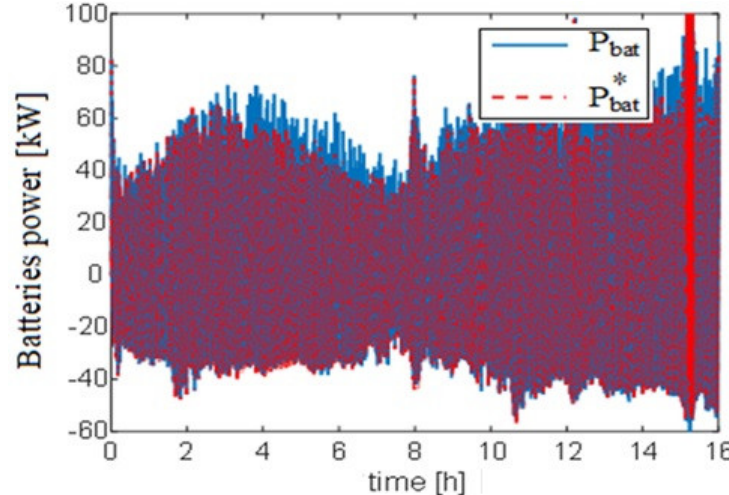
Figure 16. Vdc voltage and DC bus capacitors voltages balance control results.